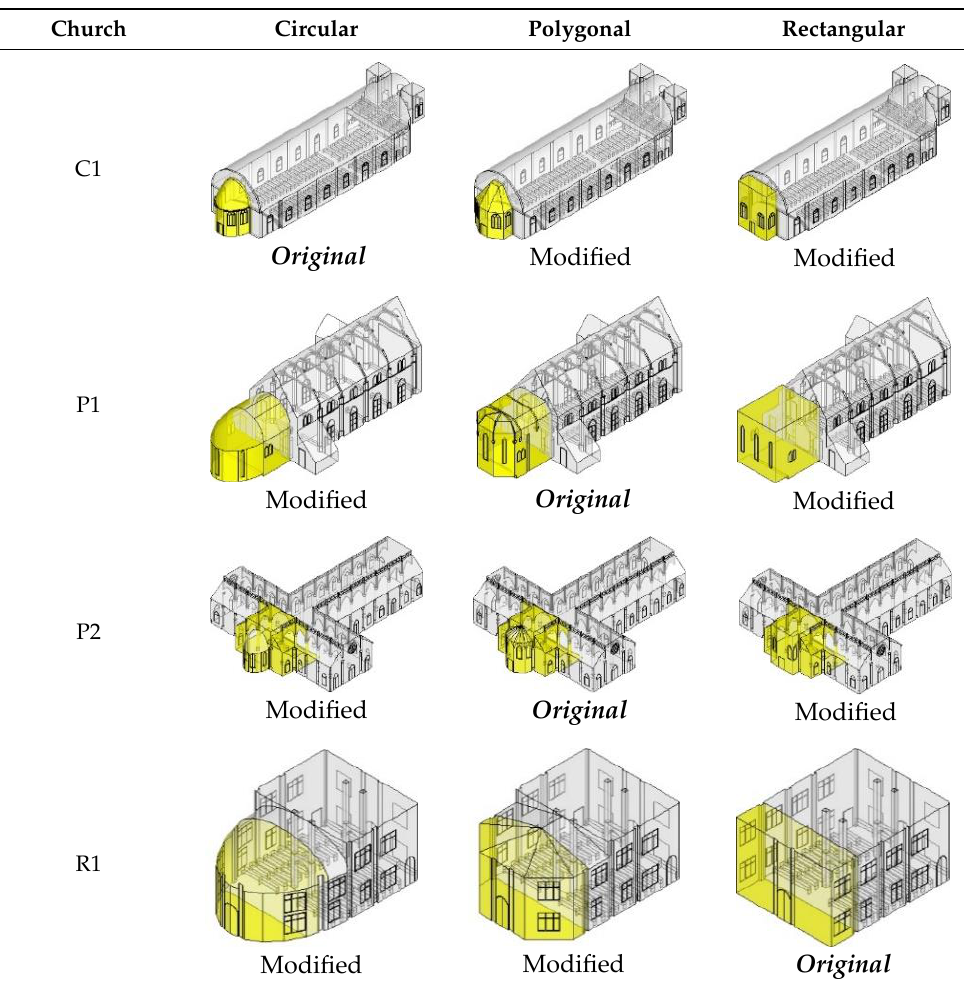
Table 4. The four churches with their original and modified chancel shapes (Simulation 2).